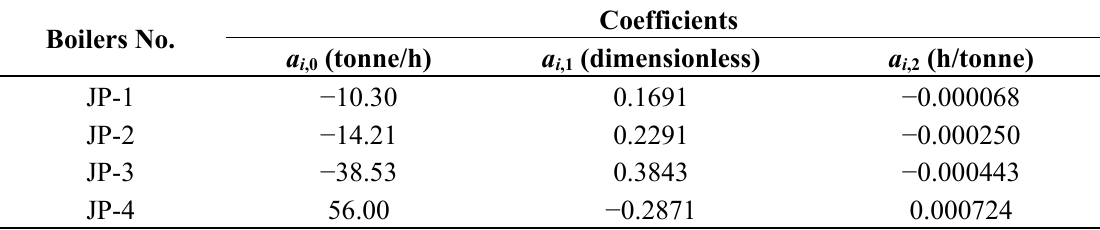
Table 2. Coefficients of I/O cost curve of the four in-plant boilers. Boilers